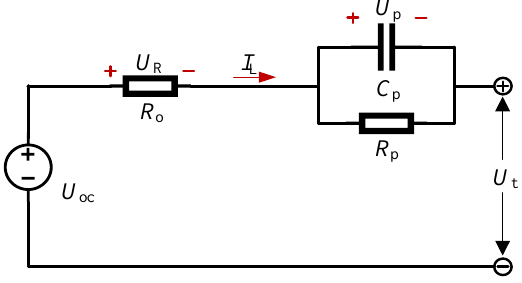
Figure 1. The schematic diagram of the first-order resistor – capacitor (RC)